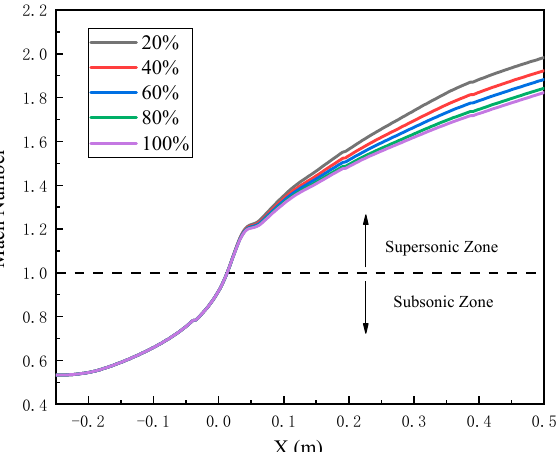
Figure 5. Pressure profile along the Moore type “B” nozzle centerline for several relative air humidity levels.